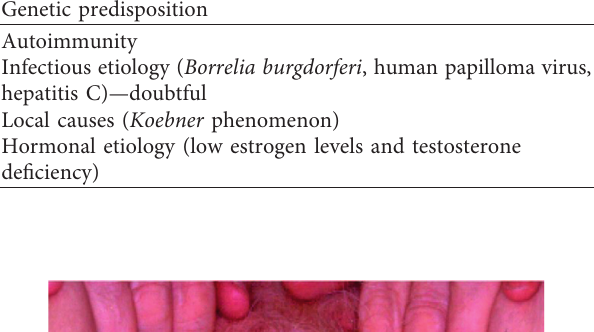
Table 1: Etiology and risk factors of vulvar lichen sclerosus. Genetic predisposition